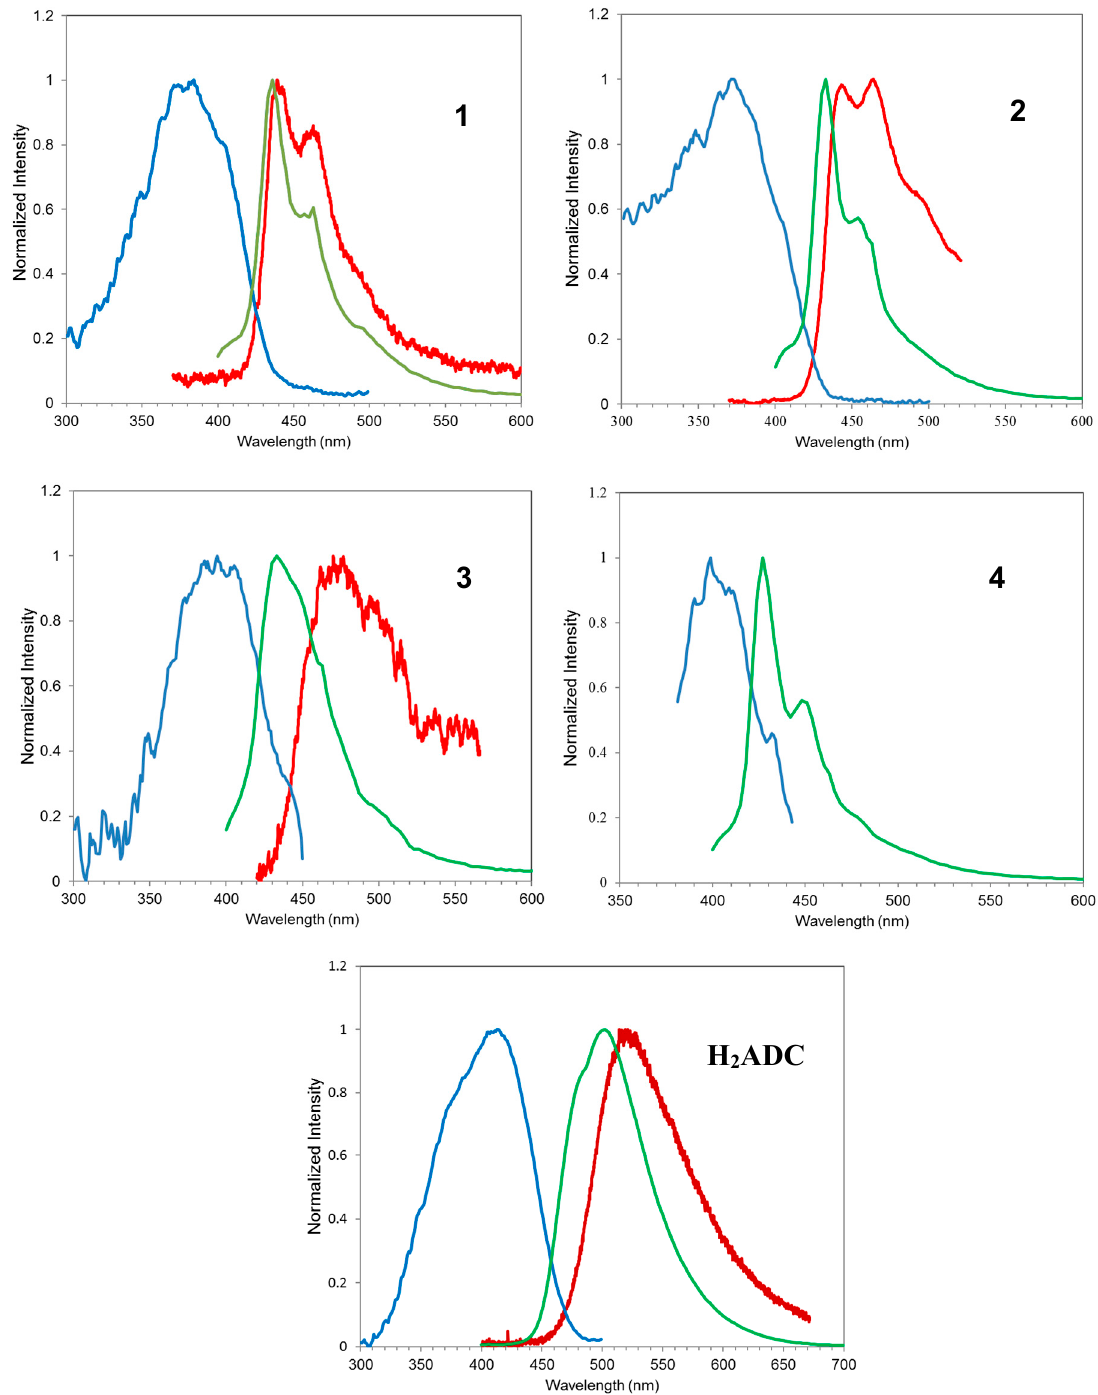
Figure 3. Photoluminescence excitation ( blue ), emission ( green ), and IBIL ( red ) spectra of 1 – 4 and H 2 ADC. (Excitation wavelength was 380 nm for all emission spectra. Excitation spectra were monitored at emission wavelength of 435 nm for 1 – 4 and at 525 nm for H 2 ADC. IBIL spectrum was not recorded for 4 ). Time-resolved photoluminescence decay : Time-resolved photoluminescence measurements were also acquired to further investigate the local environment of the anthracene units in the 3-D